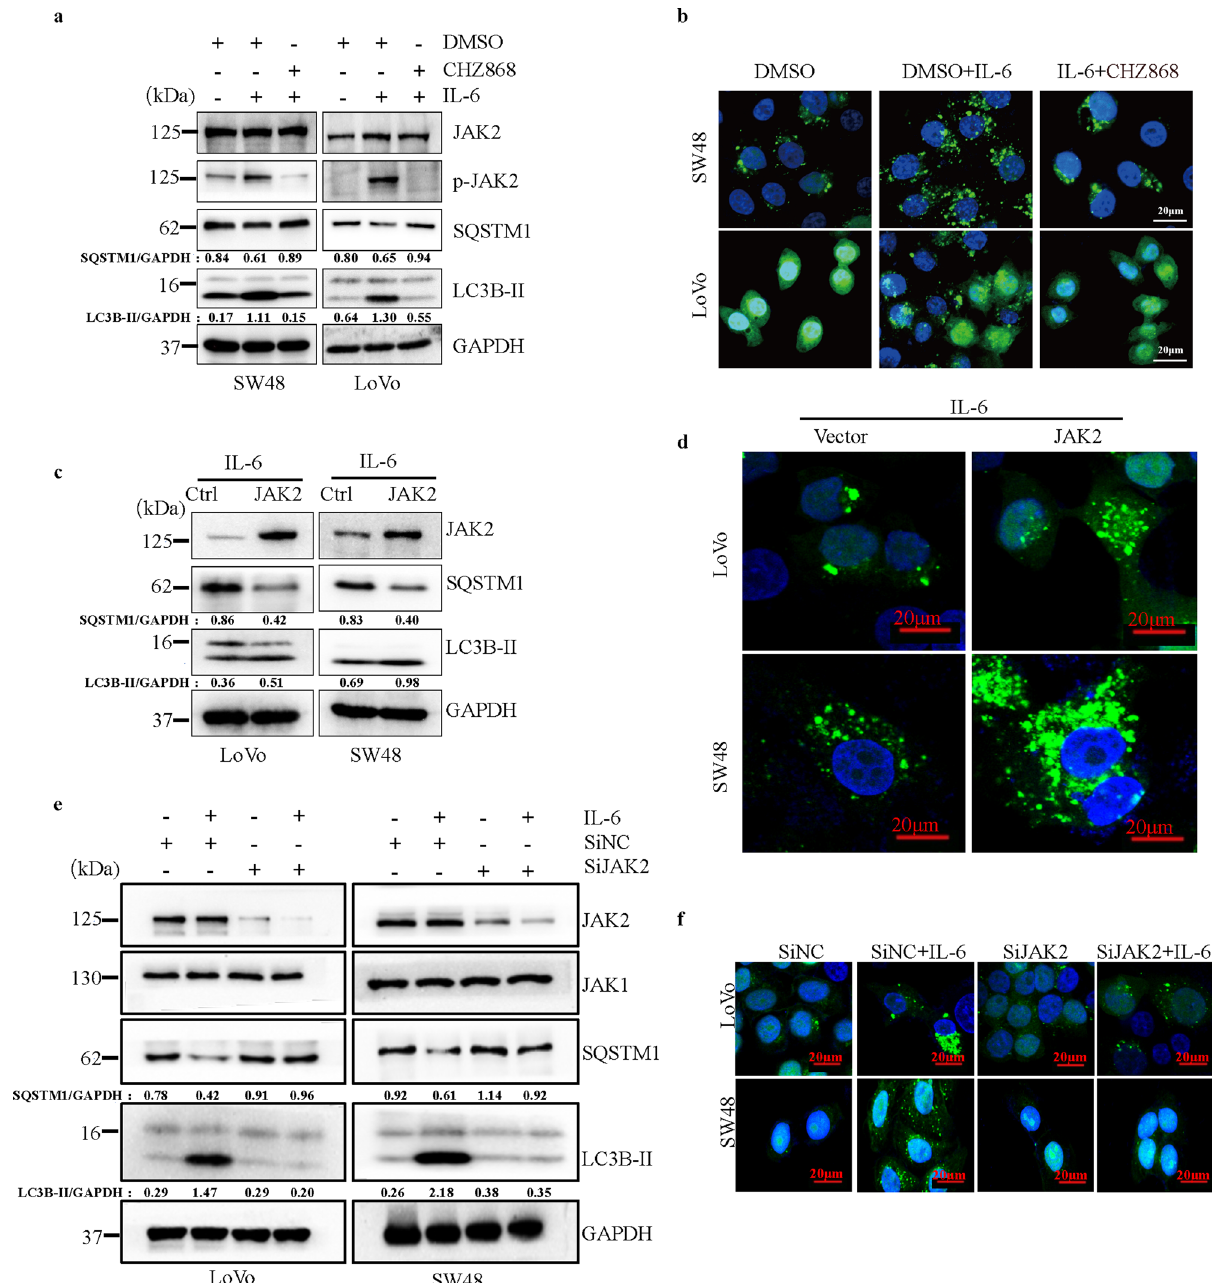
Fig. 2 IL-6 promotes autophagy in a JAK2 signaling-dependent manner. a Western blotting was performed for SW48 and LoVo cells separately treated with IL-6 (20 ng/ml) in the absence or presence of CHZ868 (0.2 μ M) for 12 h ( n = 2 independent experiments). b SW48 and LoVo cells stably expressing the GFP-LC3B fusion protein were separately treated with IL-6 (20 ng/ml) in the absence or presence of CHZ868 (0.2 μ M) for 12 h. Confocal microscopy images are shown. Scale bars, 20 μ m ( n = 3 independent experiments). c SW48 and LoVo cells were separately transfected with the JAK2 or control plasmid. After transfection for 24 h, cells were treated with IL-6 (20 ng/ml) for 12 h. Western blotting was performed to examine the expression of LC3B-II and SQSTM1 ( n = 2 independent experiments). d SW48 and LoVo cells stably expressing the GFP-LC3B fusion protein were separately transfected the JAK2 or control plasmid, and after stimulation with IL-6 (20 ng/ml) for 12 h, confocal microscopy images were obtained to measure the number of GFP puncta. Scale bars, 20 μ m ( n = 3 independent experiments). e SW48 and LoVo cells were separately transfected with small interfering RNA targeting JAK2 (SiJAK2) or small interfering RNA targeting a negative control gene (SiNC). After transfection for 24 h and following stimulation with IL-6 (20 ng/ml) for 24 h, western blotting was performed to examine the expression of LC3B-II and SQSTM1 ( n = 2 independent experiments). f SW48 and LoVo cells stably expressing GFP-LC3B fusion protein were separately transfected with SiJAK2 and SiNC. After stimulation with IL-6 (20 ng/ml) for 24 h, confocal microscopy images were obtained to measure the number of GFP puncta. Scale bars, 20 μ m ( n = 3 independent experiments). Source data are provided in the Source Data fi